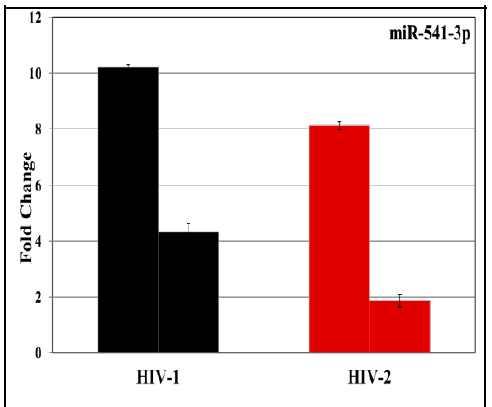
Figure 5. Total RNA was extracted using miRNeasy total RNA isolation kit (QIAGEN) from Jurkat cells infected with HIV-1 (MN) or HIV-2 (ROD) and cultured for 7 days post infection. The expression of selected miRNAs was tested in the independent samples using TaqMan MicroRNA Reverse Transcription Kit and TaqMan miRNA specific primers (Life Technologies) according to manufacturer's protocols. RNU44 was used as an internal control for each sample. Each sample was run in triplicate to ensure accurate fold change estimation. Relative miRNA expression was calculated by the ∆∆ Ct method. Results expressed as mean ˘ SEM of all independent donors experiments.